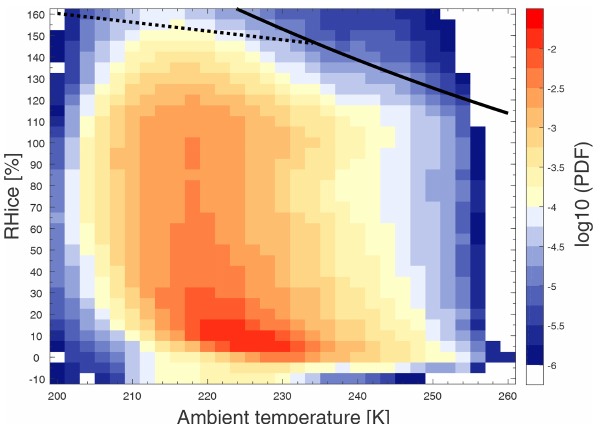
Figure 4. Distribution of RH ice for the entire MOZAIC period from 1995 to 2010 with IFC applied as a function of ambient tempera- ture with the colour indicating the probability of occurrence. The lines represent water saturation (solid line; Sonntag, 1994) and the threshold RH ice for homogeneous ice nucleation (dotted line; Koop et al., 2000; Kärcher and Lohmann,